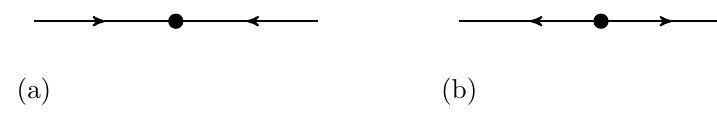
Figure 1. (a) A maximally entangled state in the Hilbert space, represented in the graphical notation. (b) A maximally entangled state in the dual Hilbert space, represented in the graphical notation.